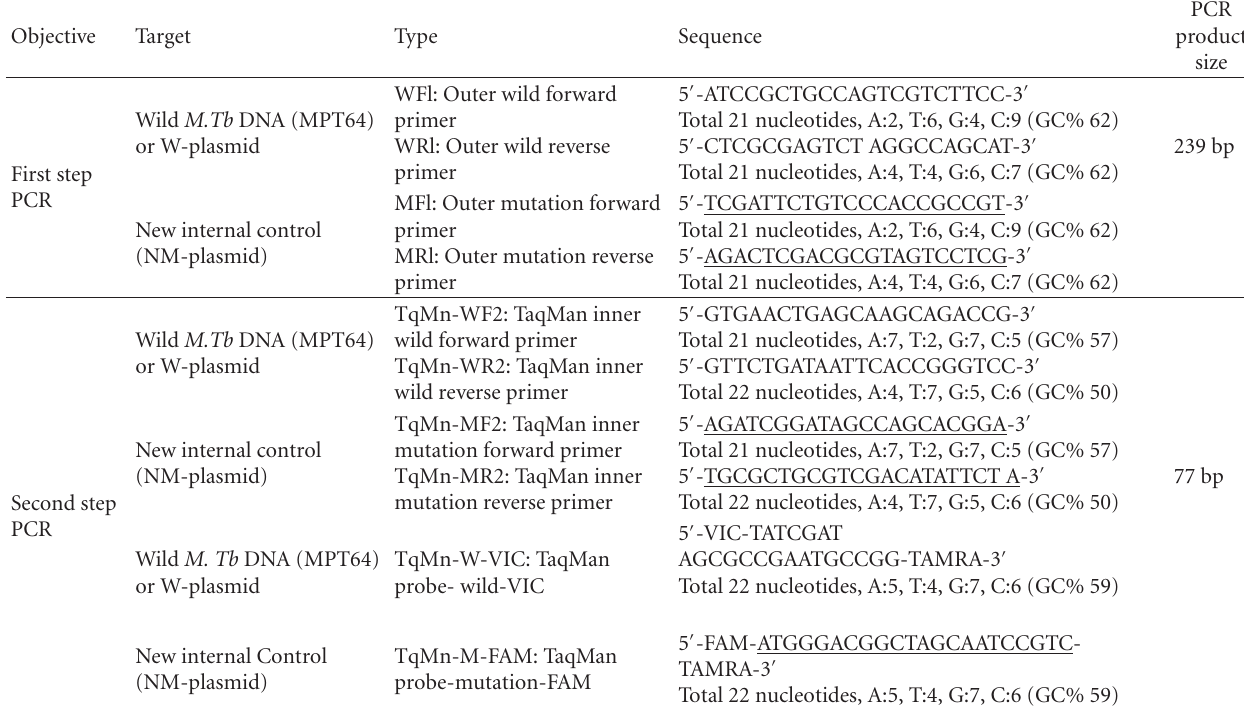
Table 2: Sequences of primers and TaqMan probes for WR-QNRT-PCR